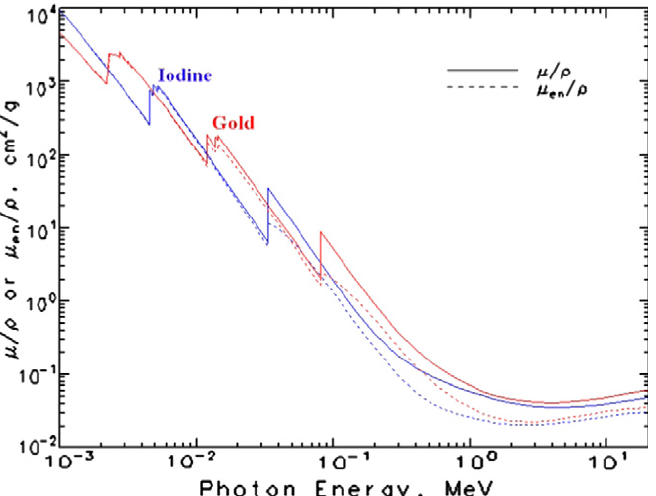
Figure 3. Energy-dependent X-ray absorption coefficients of iodine (I) and gold (Au) [51]. Adapted by permission from National Institute of Standards and Technology